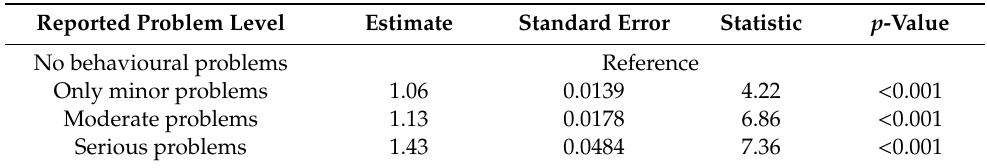
Table 3. The probability of undesirable behaviours being reported, when compared to no behavioural problems, in the self-reported categories of the unridden horse questionnaire. The more undesirable or dangerous the behaviours reported were, the higher the value scored for the horse.